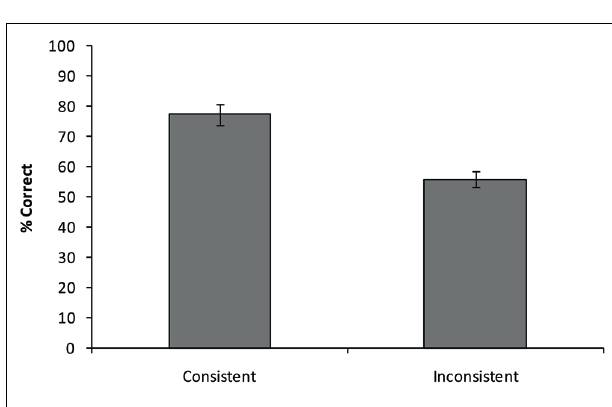
FIGURE 3 | Semantic consistency effect obtained in Experiment 1. Participants were more accurate in recognizing objects presented on a semantically consistent background, compared to a semantically inconsistent background. Error bars reflect the standard error of the